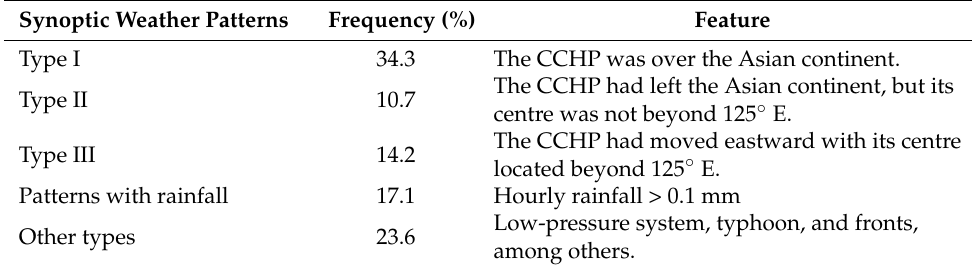
Table 4. Frequency of synoptic weather patterns influencing Taiwan from October to April between 2016 and